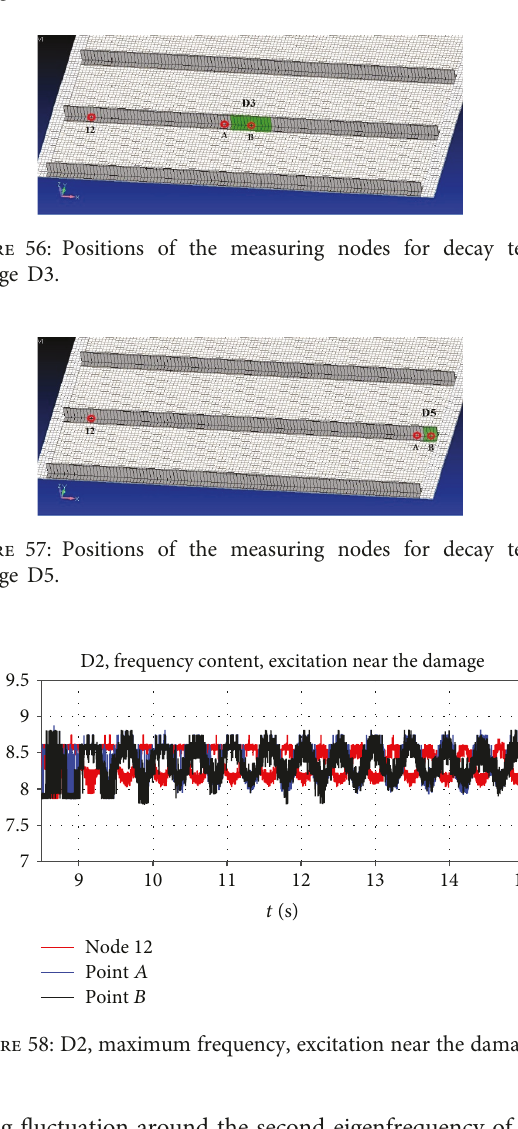
Figure 55: Positions of the measuring nodes for decay tests, damage